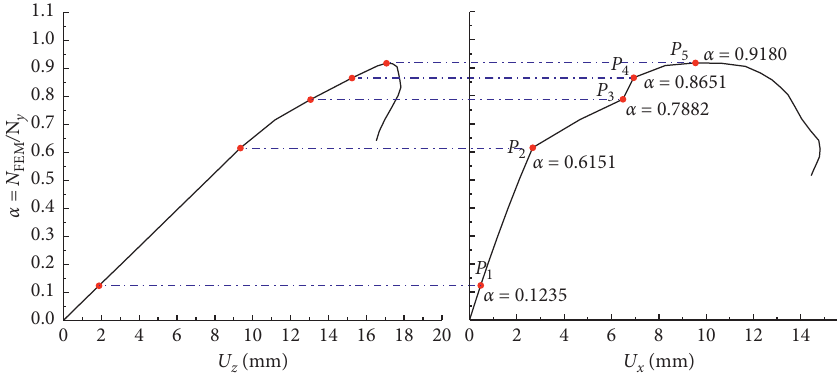
Figure 15: Load-displacement curves of D610 × 8 ( λ � 35).